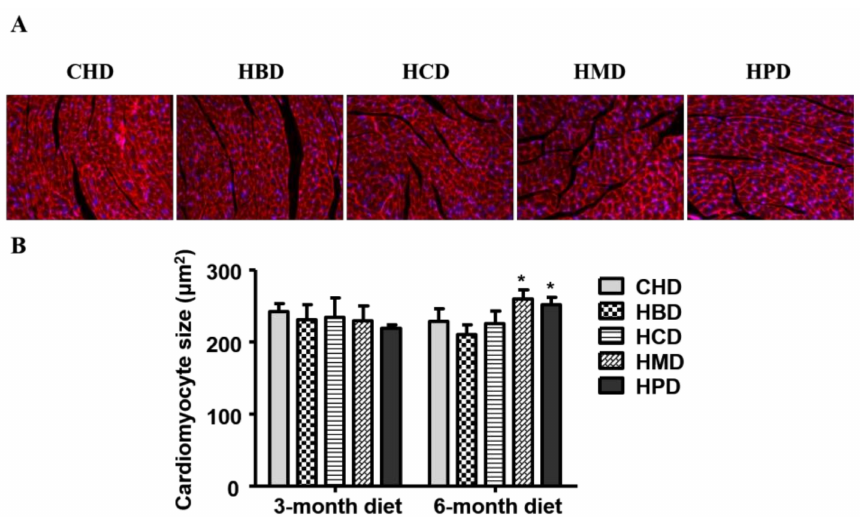
Figure 3. Histological analysis of cardiac tissue from mice fed high-fat diets. ( A ) Representative fluorescent images for cardiac tissue section from mice fed high-fat diets for six months (magnification at 200 × ); ( B ) Quantitative analysis of cardiomyocyte cross-sectional area. Data are presented as mean ± standard deviation, n = 3–5 mouse hearts in each group. * p < 0.05, compared with CHD group of 6-month